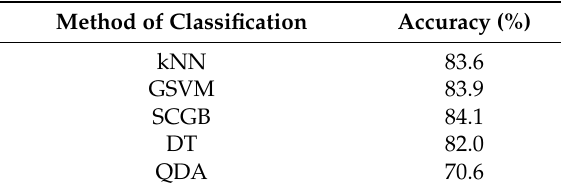
Table 8. Overall accuracies of Red-NIR-SWIR-based land cover